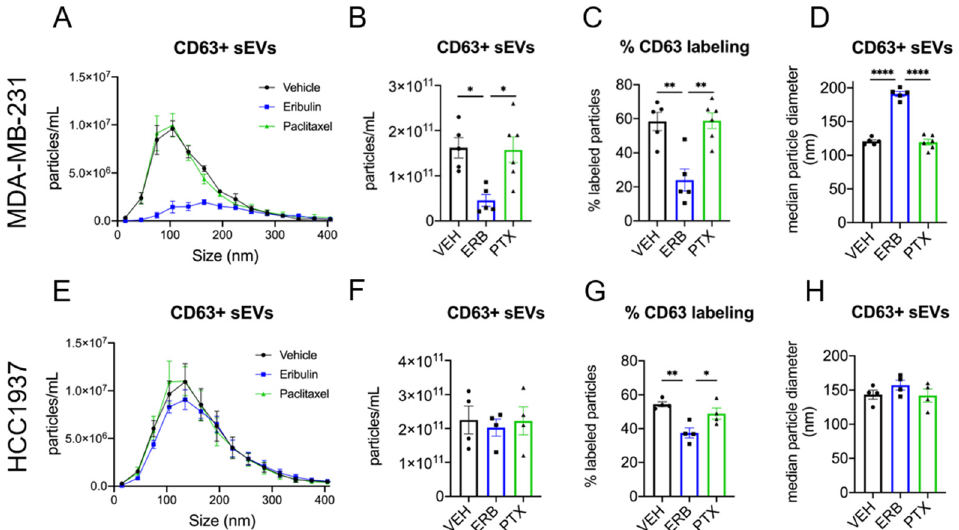
Figure 4. Fluorescent nanoparticle tracking analysis of CD63 positive sEVs. MDA-MB-231 ( A – D ) or HCC1937 ( E – H ) cells were treated for 8 h with vehicle, 25 nM eribulin, or 50 nM paclitaxel and sEVs collected from the conditioned media. Samples were labeled with anti-CD63-AF488 fluorescent antibodies to quantify CD63+ sEVs and NTA performed with the ZetaView™ in fluorescent mode to measure CD63+ particles. ( A , E ) Overlay of NTA size distribution vs. concentration graphs for each treatment measuring CD63+ sEVs. ( B , F ) The mean CD63+ particle concentration, ( C , G ) percent CD63+ particles, determined by dividing the CD63+ concentration by the total sEV concentration for each sample, and ( D , H ) median CD63+ sEV diameters for each treatment are shown. Points in the bar graphs represent the results of independent experiments and the bars represent the mean ± SEM, n = 4–6, and significance determined by one-way ANOVA with Tukey’s post-hoc test, * p < 0.05, ** p < 0.01, **** p < 0.0001.